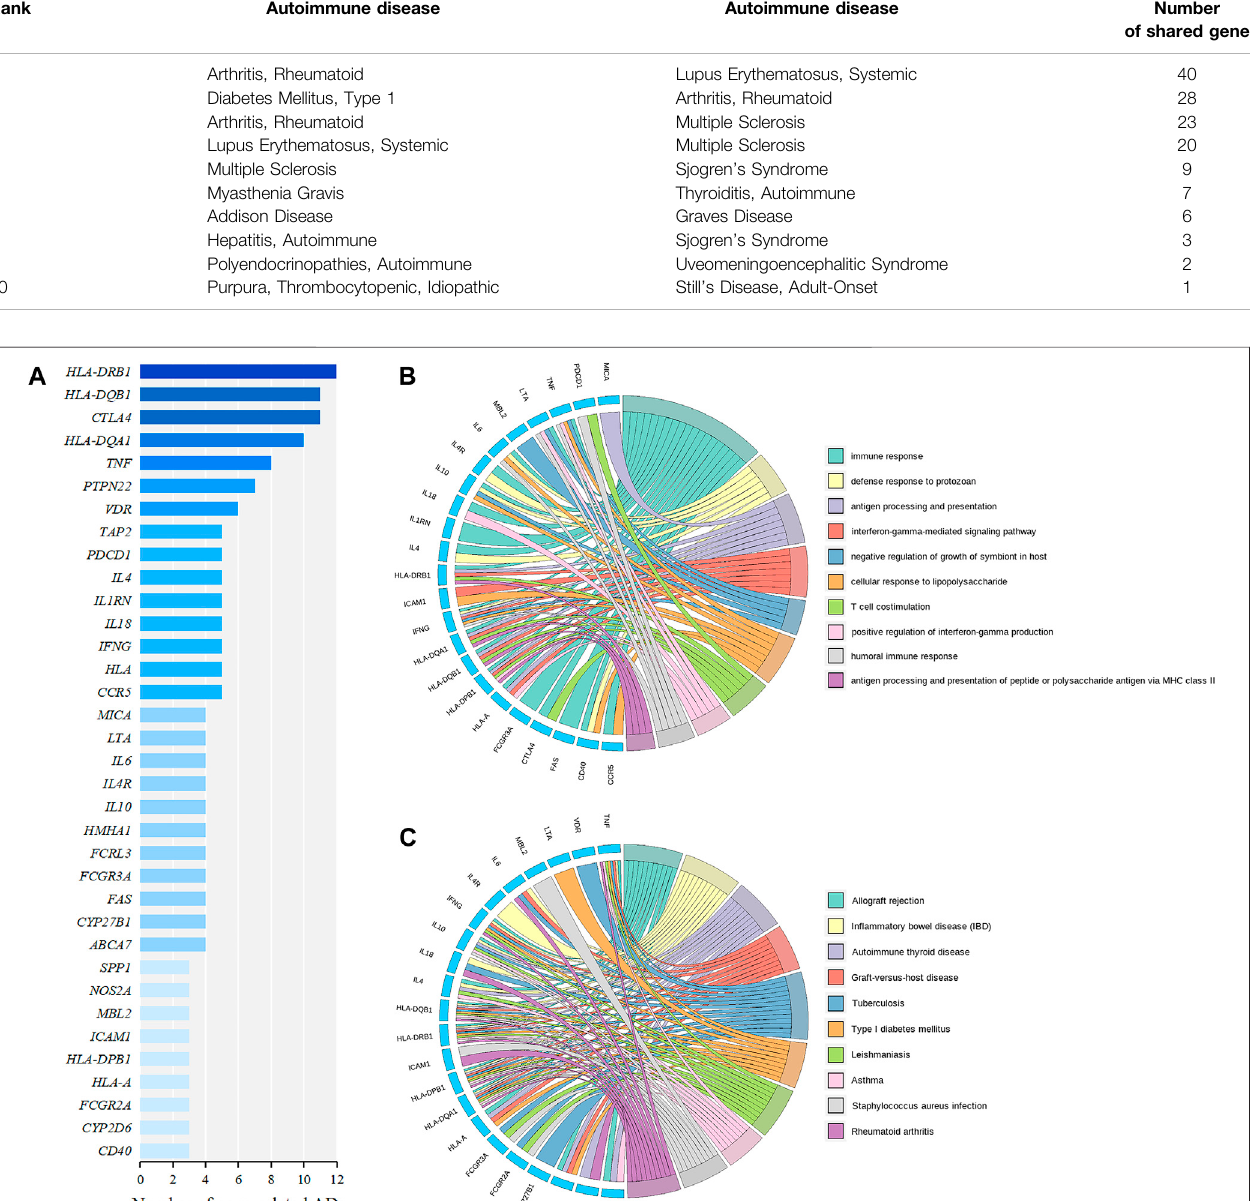
Frontiers in Genetics |